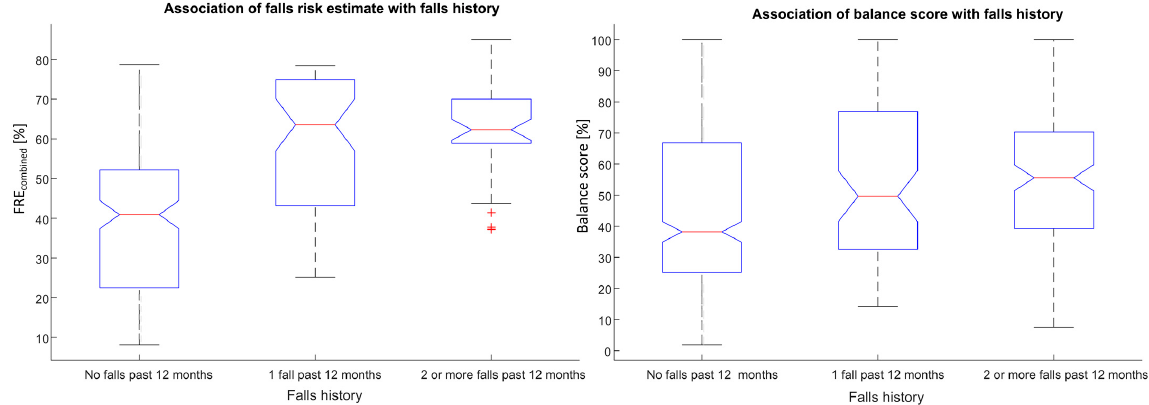
Figure 5. Associations between falls risk ( FRE combined ) and Balance scores with self-reported falls history for unsupervised assessments obtained using a smartphone.